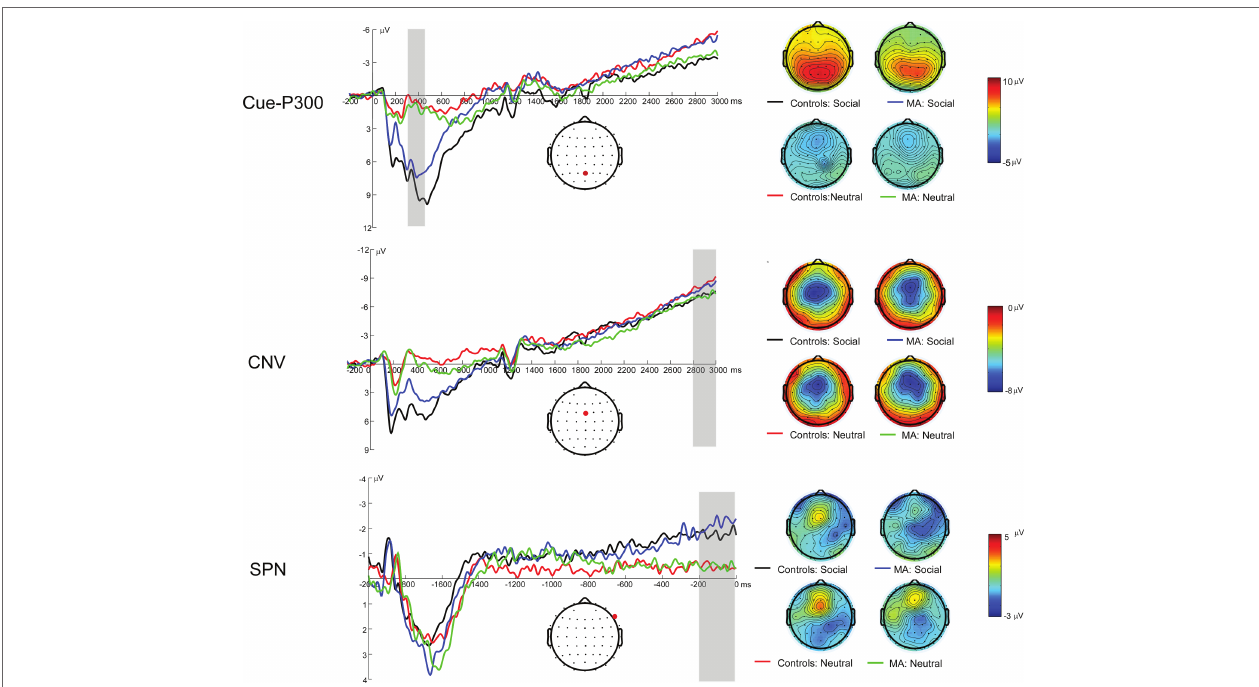
FIGURE 2 | Left: Anticipatory ERP responses to social incentive and neutral trial conditions on SID. The Cue-P3 was scored as the average activity from 300 to 450 ms following cue onset (top). The CNV was scored as the average activity from 2,800 to 3,000 ms following cue onset (middle). The SPN (bottom; 200–0 ms prior to feedback onset) was scored as the average in the shaded window. Right: The topmap scalp distributions of the incentive and neutral trials for the Cue-P3 (top), CNV (middle), and SPN (bottom) for